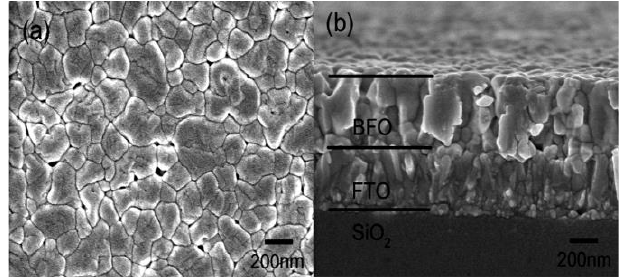
Figure 22. SEM image of a BFO film: ( a ) topography; ( b ) cross – section [67].